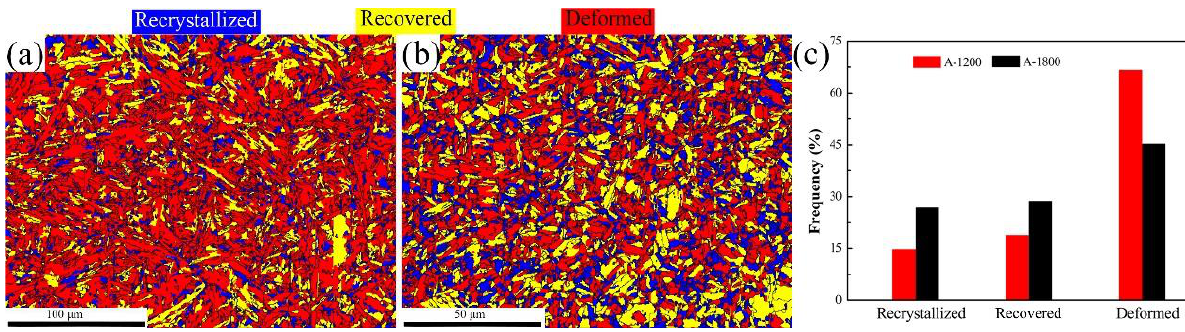
Figure 10. EBSD recrystallization maps of ( a ) A-1200 and ( b ) A-1800 steels, as well as ( c ) volume fractions of recrystallized, recovered, and deformed regions.